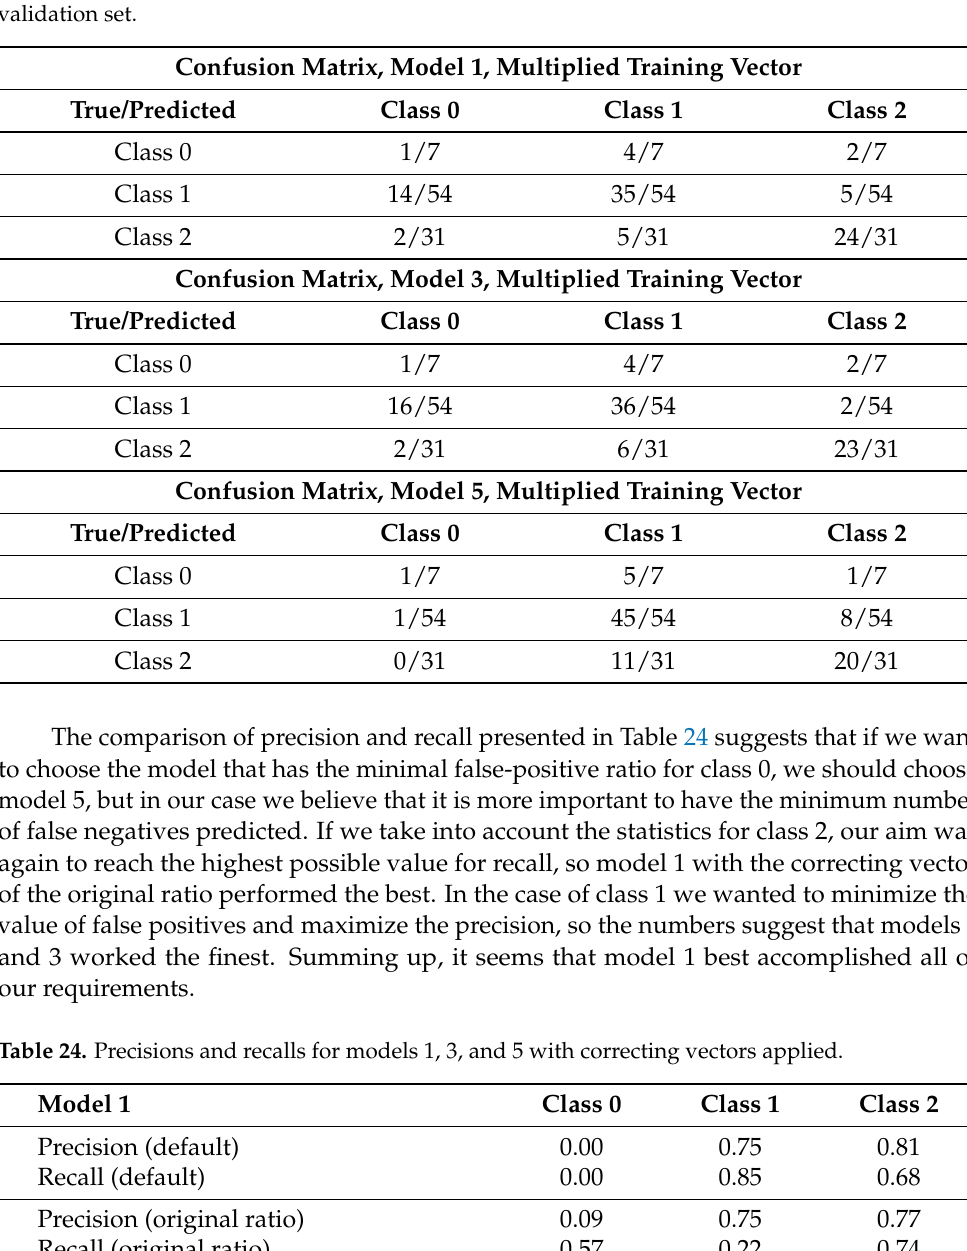
Table 23. Confusion matrices for models 1, 3, and 5, corrected with multiplied training vector on the validation set.